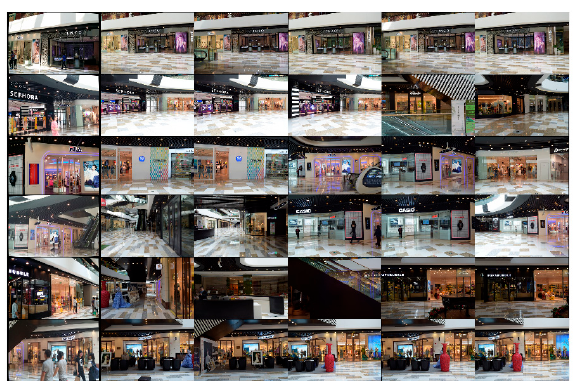
Figure 9. Percentages of localized images from the Baidu data set across position error thresholds. The reported results partly come from paper [56]. The orientation error threshold is 5°, 10°, and 20° for position errors below 1 m, between 1 m and 2.5 m, and above 2.5 m, respectively. Ours (50) means we used the optimized training scheme and retrieved 50 images in prior image retrieval stage. Ours (100) means we used the optimized training scheme and retrieved 100 images in prior image retrieval stage. Ours (Basic VAE, 50) means we did not use the optimized training scheme in the VAE training stage and retrieved 50 images. Ours (Basic VAE, 100) means we did not use the optimized training scheme in the VAE training stage and retrieved 100 images.